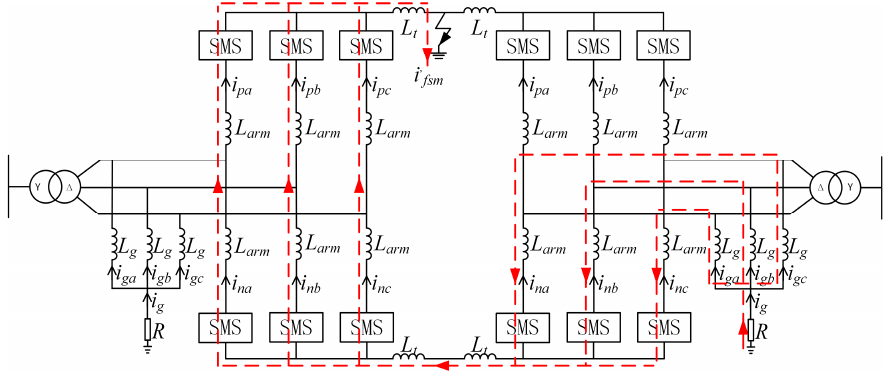
Figure 9. Fault current circuit in double-terminal MMC during positive pole-to-ground fault.